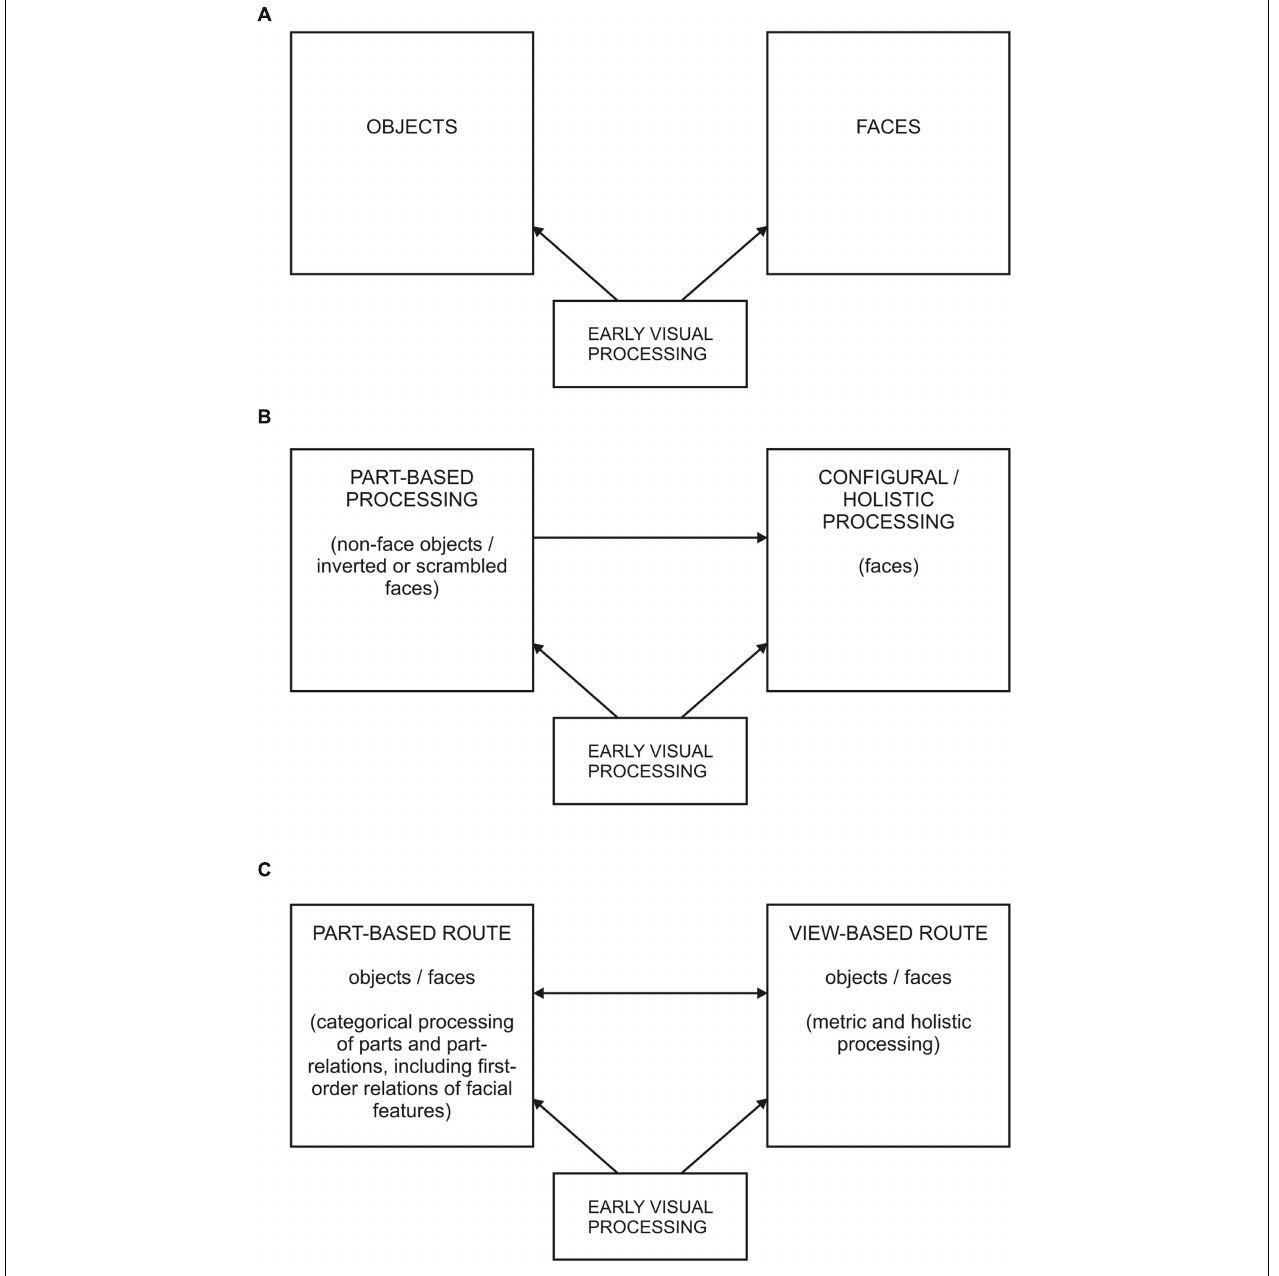
FIGURE 2 | Three different models relating object and face perception. (A) According to the model by Farah (adapted from Farah, 1996) object and face processing are largely independent from each other. (B) Holistic/part-based model of Piepers and Robbins (adapted from Piepers and Robbins, 2012). Here face perception is assumed to be supported by both part-based and configural/holistic processing whereas object perception is only part-based. (C) Proposed dual-route framework for the processing of objects and faces, consisting of a categorical, part-based and a metric, view-based pathway. The two routes operate in parallel but can also augment each other. Their relative contribution is assumed to depend on stimulus domain as well as on task, and to be modulated by developmental